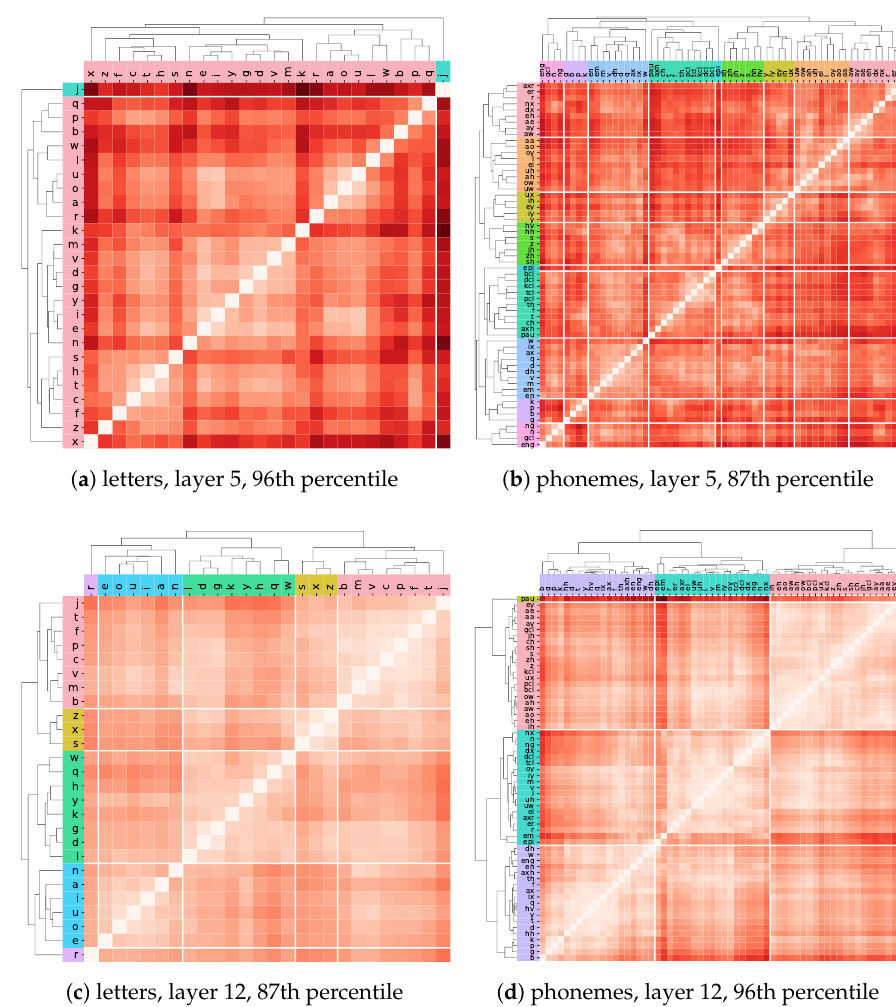
Figure 9. Clustermaps of SNAPs of the W2L model in layers 5 and 12 using grouping by predicted letter and annotated phoneme. Each subfigure shows the clustering at the respective percentile of best quality according to Silhouette score. Equal heat map colors represent same distance values in the same layer, but are not comparable between layers. Colors of clusters in different plots do not represent mapping of the clusters. An enlarged view of the clustering without the heat map of pairwise distances is shown in Figure